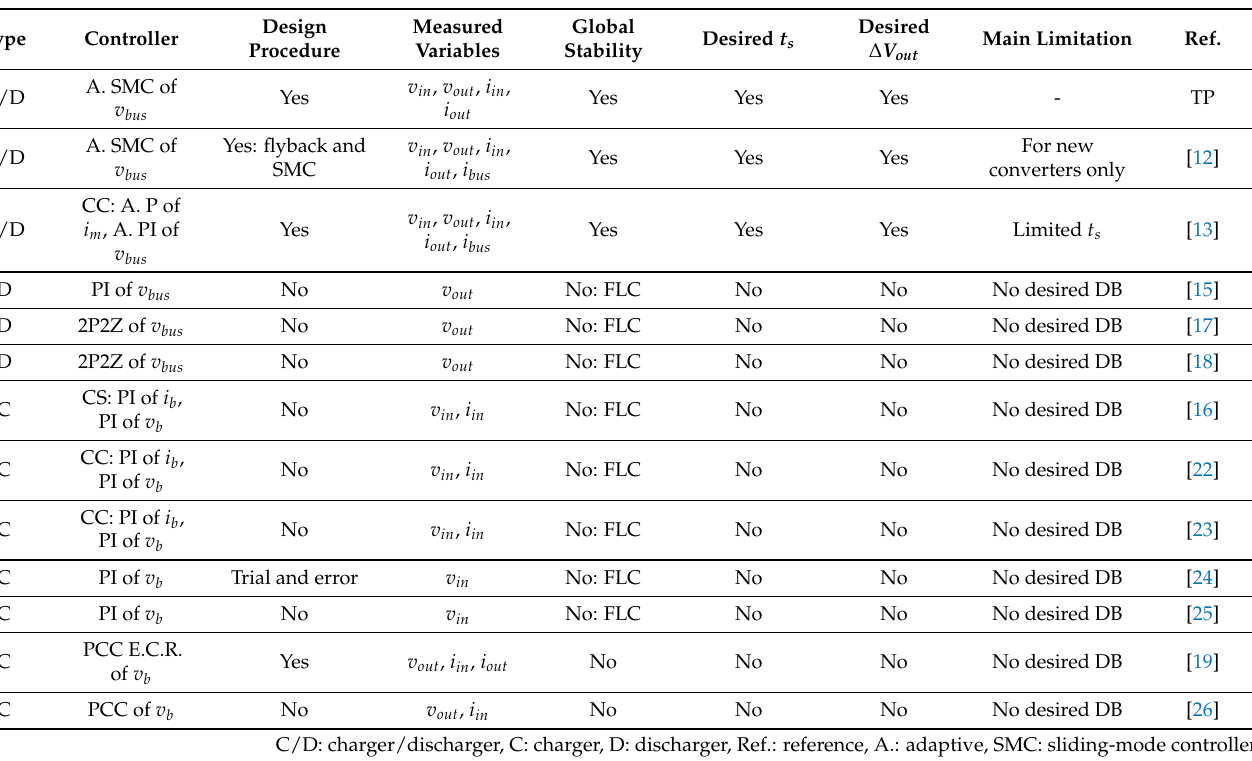
Table 1. Controllers comparison of flyback-based battery charging, discharging, and charging- discharging